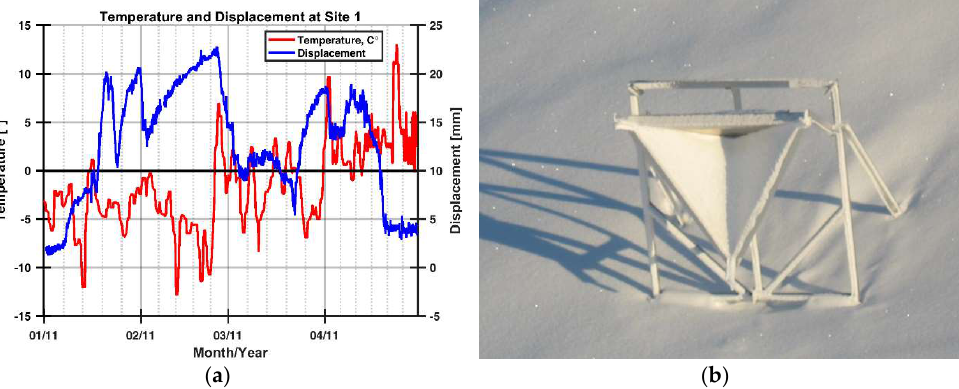
Figure 12. ( a ) Variation in path length and estimated temperature profile as a function of time at